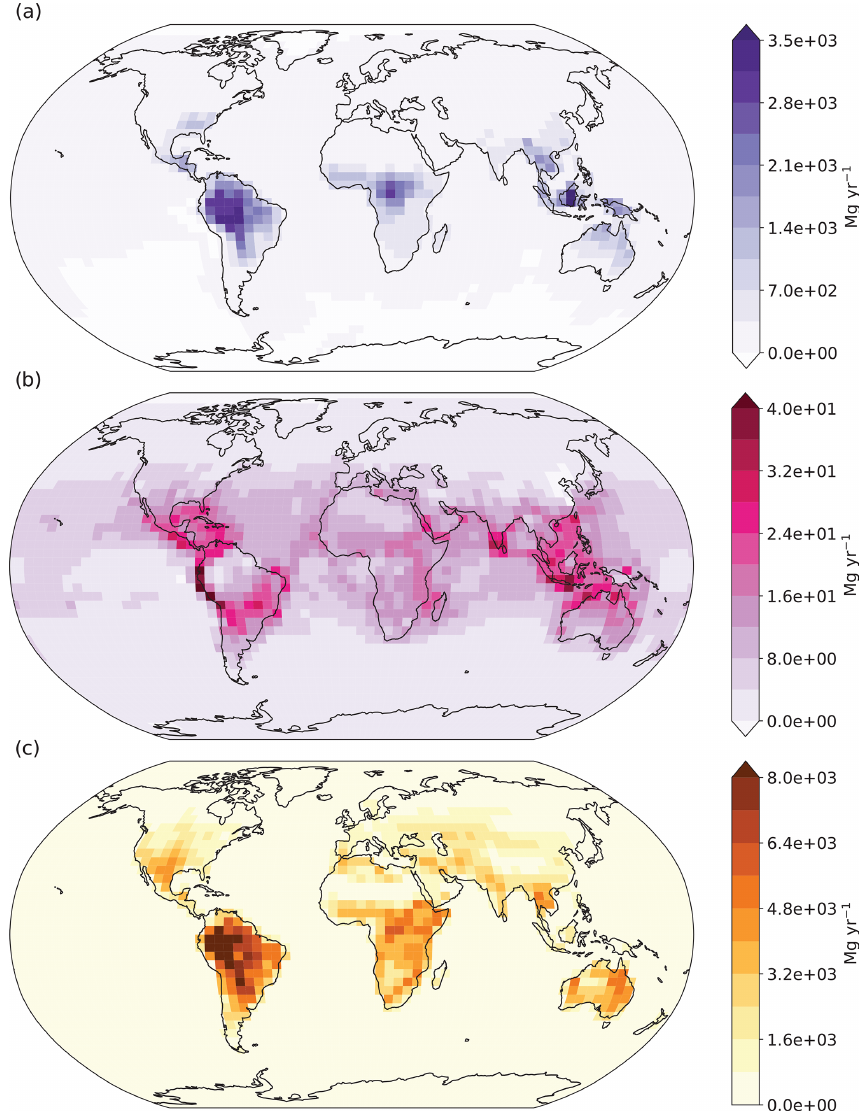
Figure 8. Absolute differences at the modeled surface layer between the aldehyde photolysis scenario (with 1% quantum yield of H 2 from aldehydes) and the baseline simulation for (a) H 2 chemical production, (b) H 2 chemical loss, and (c) H 2 uptake by soil. Units for all plots are megagrams per year (Mgyr − 1 ). Note the differences in scale between the